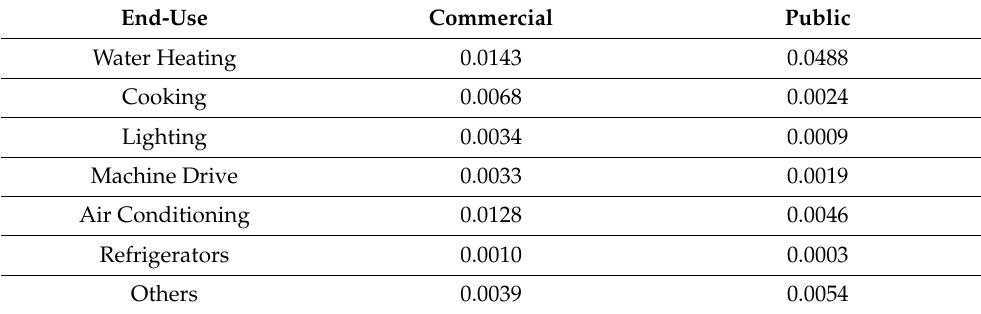
Table 4. Useful energy intensity in MJ/COP